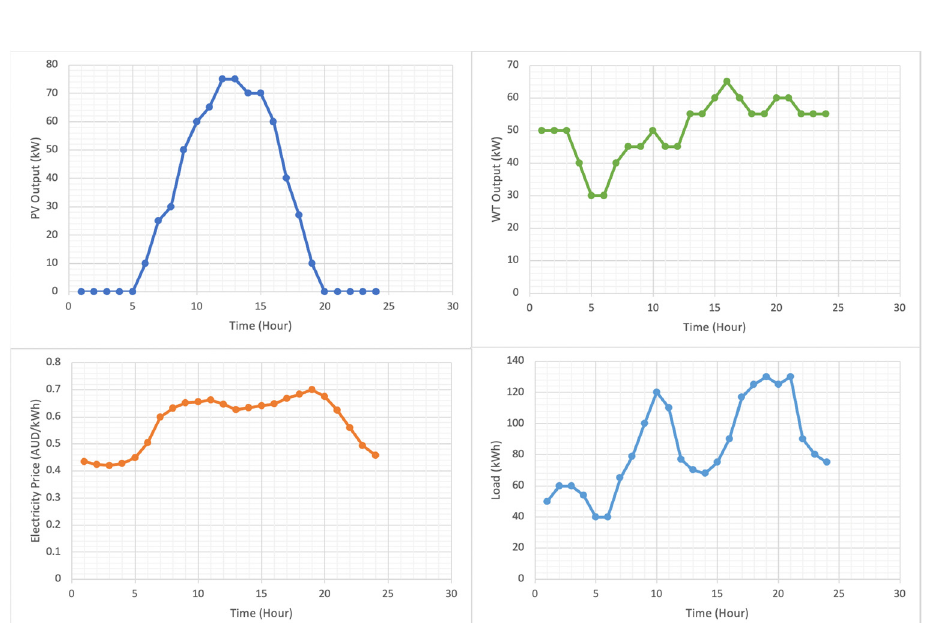
Figure 3. Profiles of input parameters .